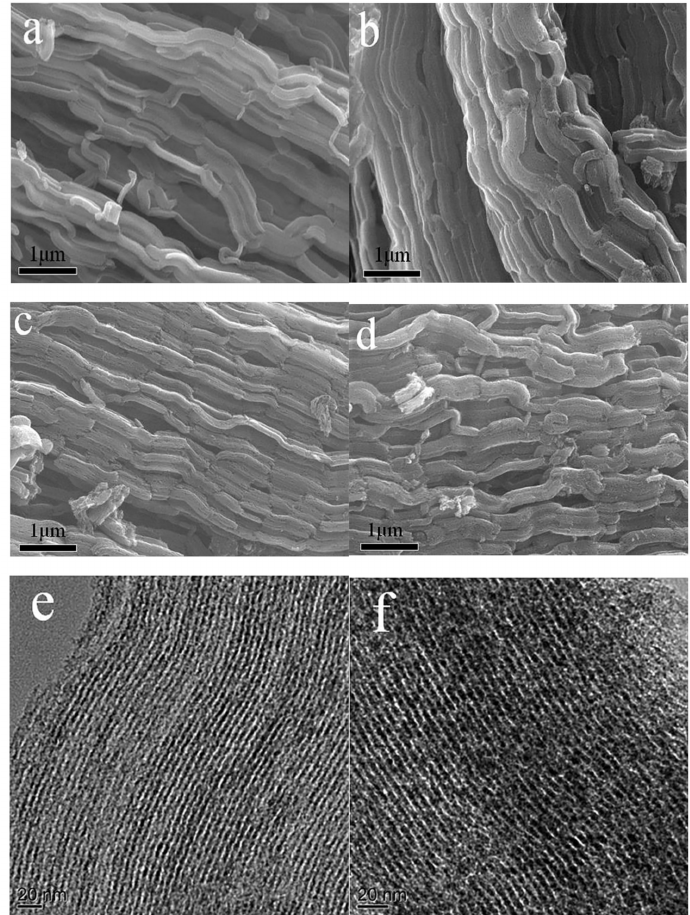
Figure 3. SEM images of ( a ) NCM-700, ( b ) NCM-800, ( c ) NCM-900, and ( d ) ACNCM-900; TEM images of ( e ) NCM-900 and ( f )